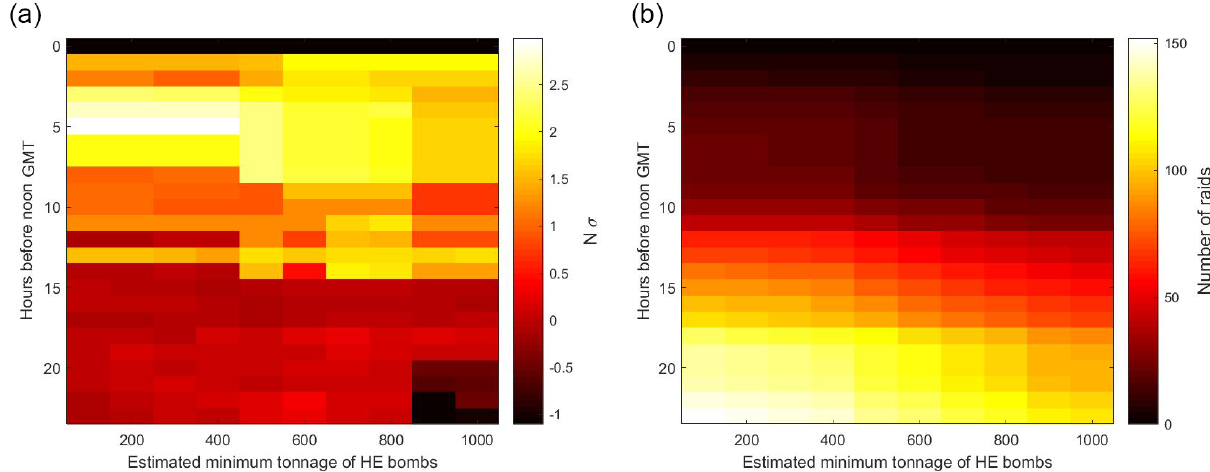
Figure 2. Panel (a) presents the relative significance of the ionospheric response at time zero (estimated standard deviations from the mean) for a range of thresholds. Events preceding the ionospheric measurements were considered for time windows from 0 to 23h ahead of the noon ionospheric measurement and the minimum tonnage of HE bombs used in each raid was also varied from 100 to 1000t. The most significant ionospheric response occurred for events occurring within 5h before noon, in which a minimum of 300t of HE bombs were dropped. Panel (b) presents the number of events contributing to each analysis. The significance of the response decreases if the threshold is extended beyond 5h ahead of the ionospheric measurement. This indicates that events occurring at larger time offsets are not contributing to the observed median response. The significance of the result 5h ahead decreases as the threshold on the minimum tonnage of HE bombs increases. This is likely due to the decreasing number of events contributing to each